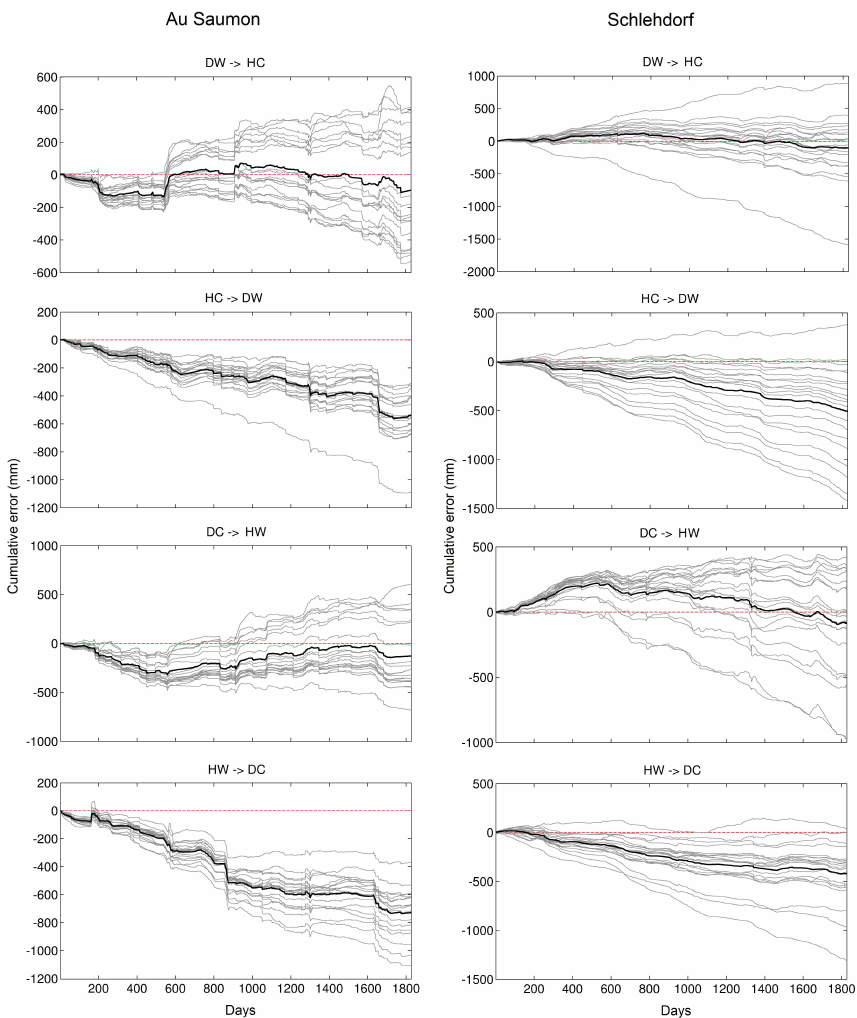
Fig. 10. Cumulative error between observed and simulated discharges for all the DSS tests in validation, for the Au Saumon and Schlehdorf catchments. Grey lines are the twenty individual models, large black line is the twenty-member ensemble and the horizontal dashed line indicates the optimal